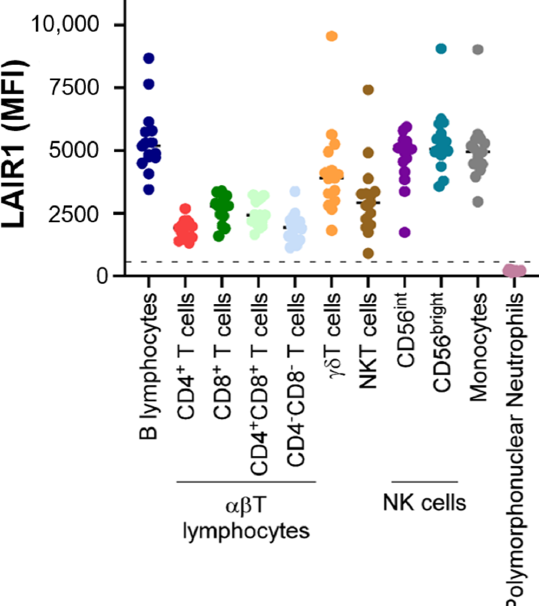
Figure 2. LAIR1 expression in normal white blood cells. LAIR1 expression was evaluated by flow cytometry (FCM) in a total of 10 samples obtained from healthy adult subjects ( n = 10 blood samples, median age: 31 (range: 21–63); gender (male/female): 3/7) after red blood cell lysis by Versalyse© Beckman Coulter. For technical procedures, see [14]. Age (median): 31 (range: 21–63); gender (male/female): 3/7. Monocytes and granulocytes were selected based on their well-known CD45/side scatter (SSC) profile. In the “lymphocyte gate” determined on the graph CD45/SSC, T lymphocytes, NK cells, and B lymphocytes were selected according to the respective criteria of expression of CD3, absence of expression of CD3 and CD19 and expression of CD56, and expression of CD19 and CD20. The results obtained for the mean fluorescence intensity (MFI) of LAIR1 are presented. The dotted line represents the positivity threshold for this marker.